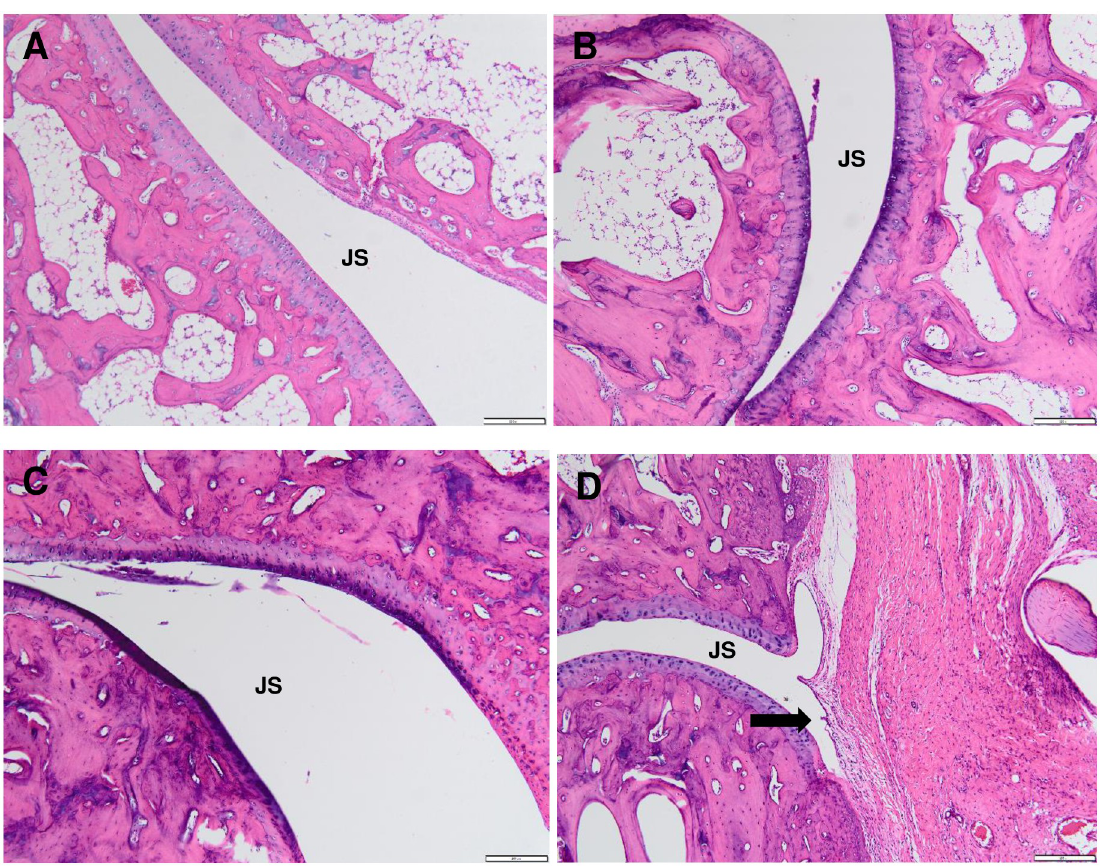
Fig 9. Representative histological sections of ipsilateral ankle joint by haematoxylin and eosin (H&E) staining at 100x magnification in control (A), polyarthritic rat inoculated with CFA at 5.0 mg/mL (CFA 5.0) (B), 7.5 mg/mL (CFA 7.5) (C) and 10.0 mg/mL (CFA 10.0) (D). (A) In the control group, smooth articulation of the joint cartilage surface, regular joint space (JS) with the normal connective tissue of the synovial membrane were observed. Meanwhile, ipsilateral ankle joint of rats in CFA 5.0 (B) and CFA 7.5 (C) groups showed mild penetration of inflammatory cells into the synovial cavity, indicating suppressed joint pathology and less soft tissue swelling. Additionally, the synovial hyperplasia with extensive inflammatory cells infiltration (as shown by the purplish stains), bone resorption and severe cartilage destruction indicating the narrowing of the joint with inflammatory cell infiltration into the synovial cavity (arrow) were found in the ipsilateral ankle joints of CFA 10.0 group.